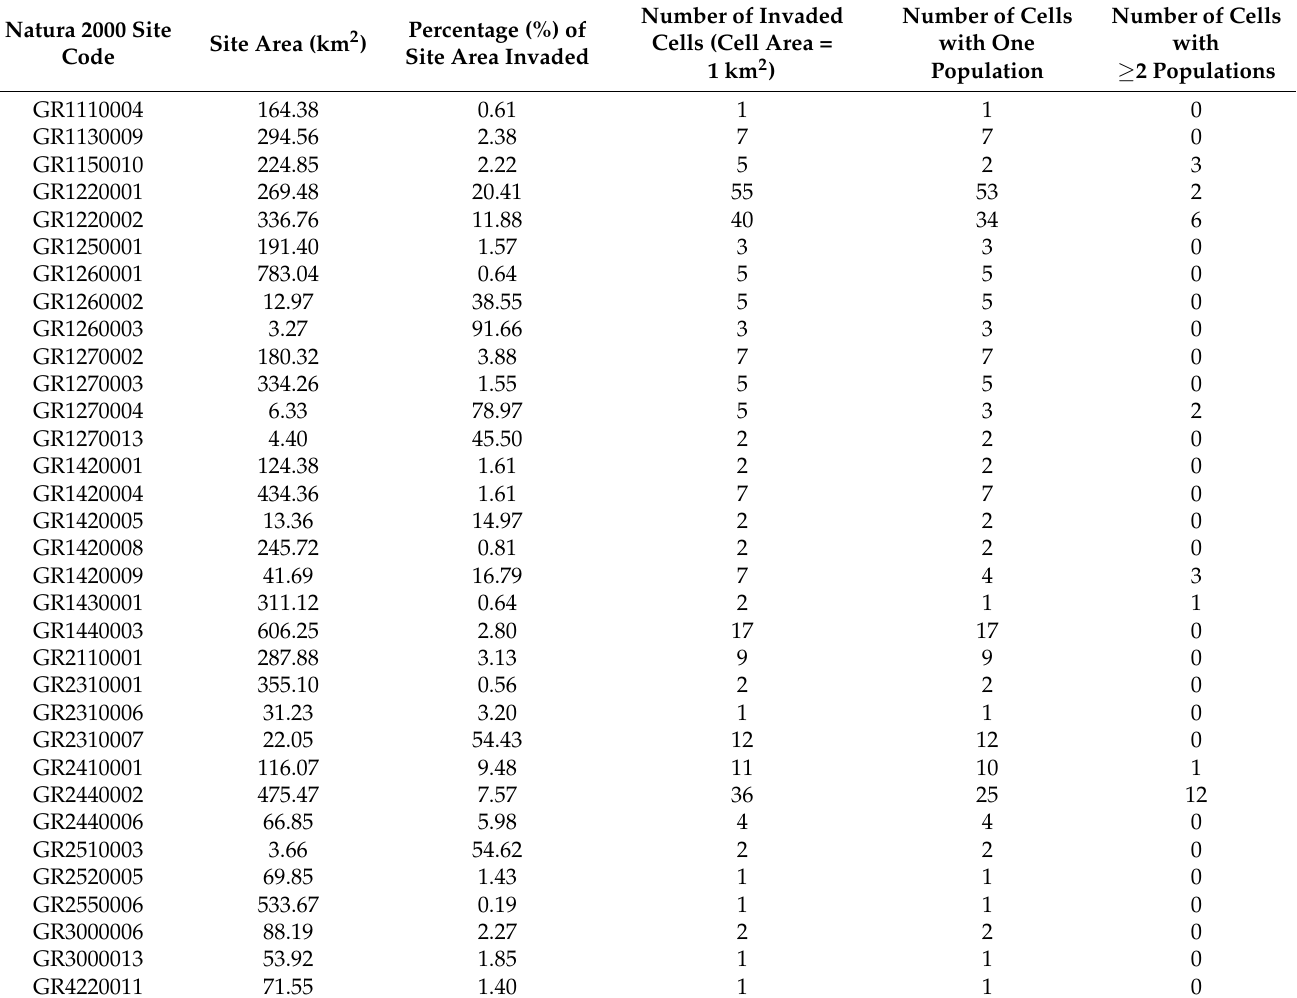
Table 1. Greek Natura 2000 sites invaded by the alien invasive species Solanum elaeagnifolium outlining the percentage of the site area invaded, the total number of cells invaded, and the number of cells invaded by one or more